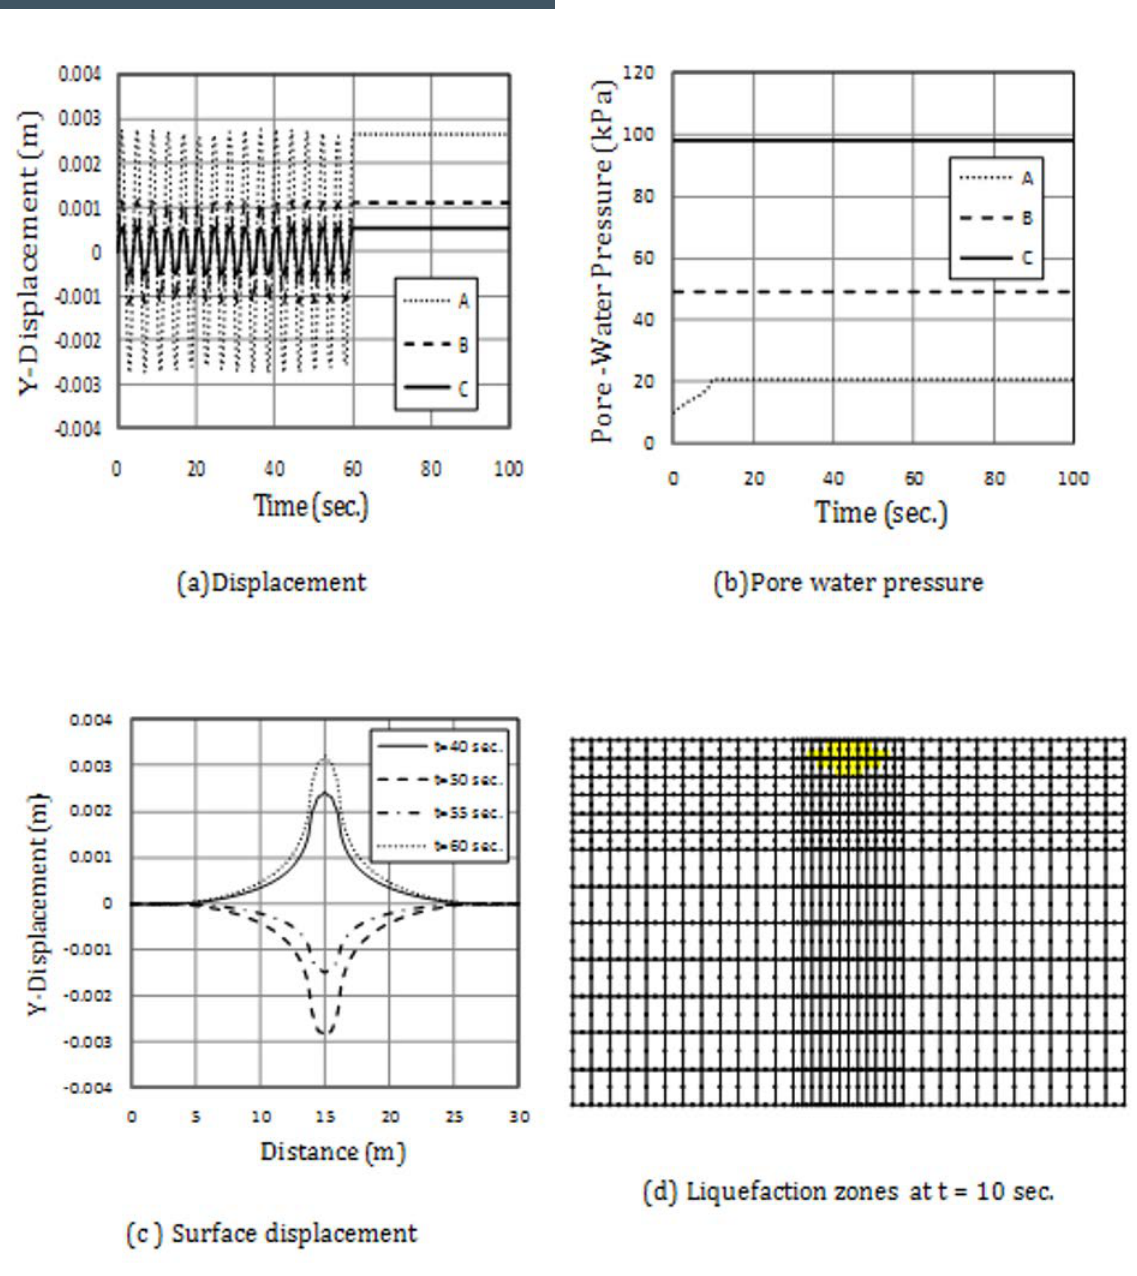
Figure 14. Dynamic response of the foundation to harmonic load, a